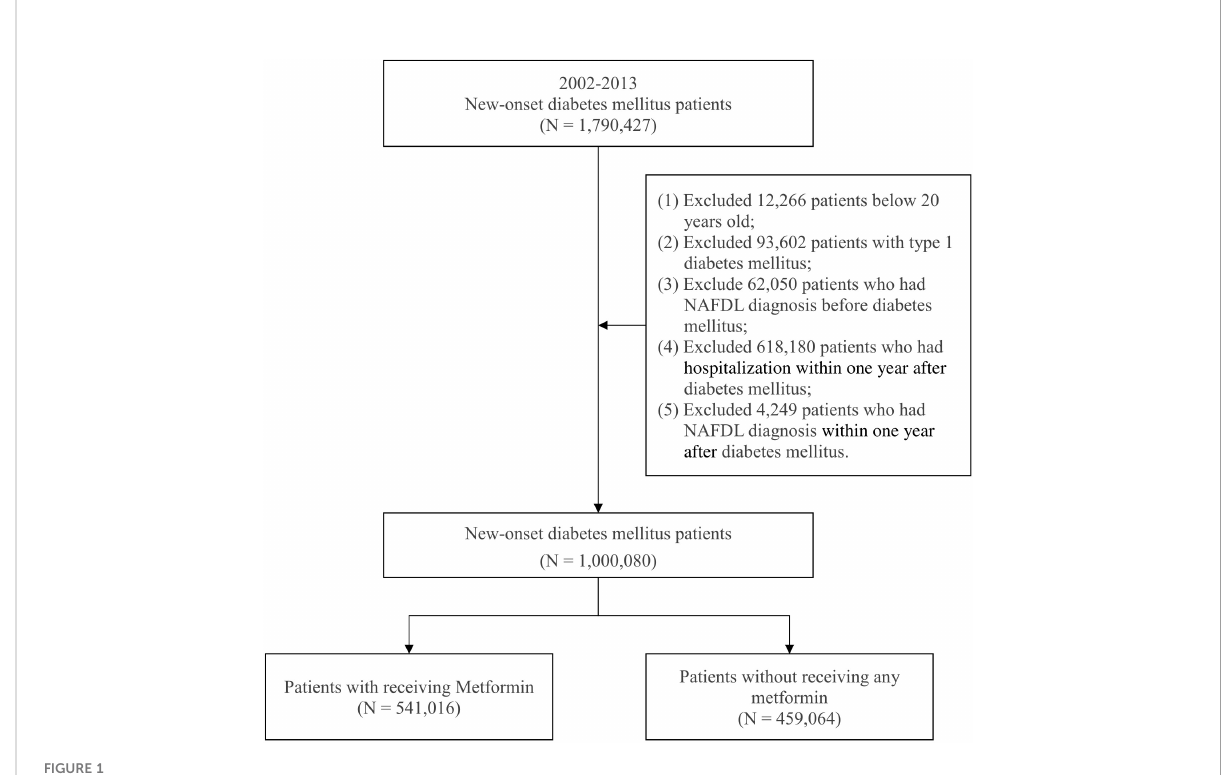
FIGURE 1 Patient selection